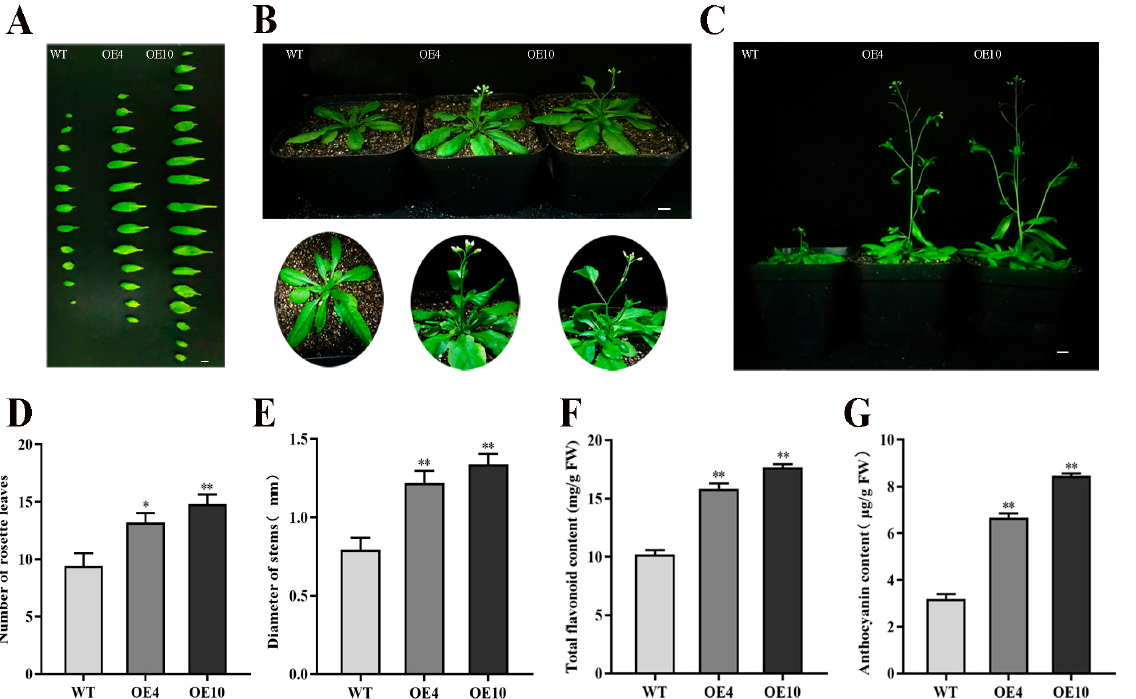
Figure 7. Phenotypic analysis and quantification of total flavonoids and anthocyanin content in two transgenic OE lines of Arabidopsis (OE-4 and OE-10) and WT. ( A ) Leaf morphology of CtC4H1 transgenic OE and WT plants ( B ) phenotypic analysis of CtC4H1 transgenic OE and WT seedlings in the soil ( C ) stem growth of CtC4H1 transgenic OE and WT plants. Bars = 1 cm ( D ) Number of rosette leaves. ( E ) Diameter of stems. ( F ) Total flavonoids content of WT, CtC4H1 transgenic lines. ( G ) Anthocyanin content of WT, CtC4H1 transgenic lines. The numerical value represents the average ± standard deviation of three biological repetitive samples. The statistics were calculated with one-way ANOVA test and significant differences between treatments were demonstrated with asterisk (* p < 0.05, ** p < 0.01).